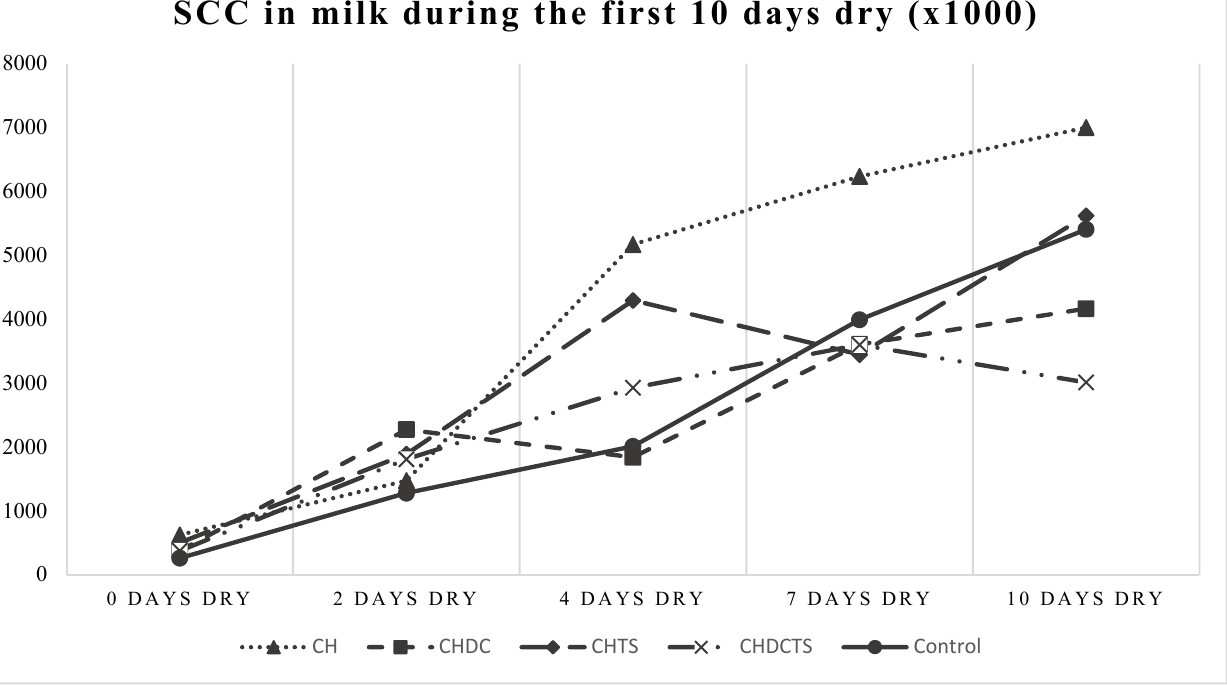
Figure 1. SCC (thousands/mL) by days dry and dry treatment group; no significant differences between treatments found. CH = casein hydrolysate; CHDC = casein hydrolysate + dry cow treatment; CHTS = casein hydrolysate + teat sealant; CHDCTS = casein hydrolysate + dry cow treatment + teat sealant; Control = dry cow treatment + teat sealant .